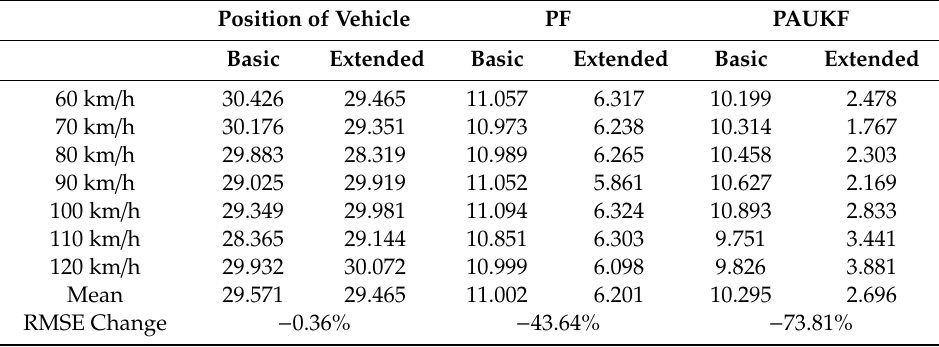
Table 3. The root mean square error (RMSE) of the basic PAUKF and the extended PAUKF in di ff erent conditions (unit: